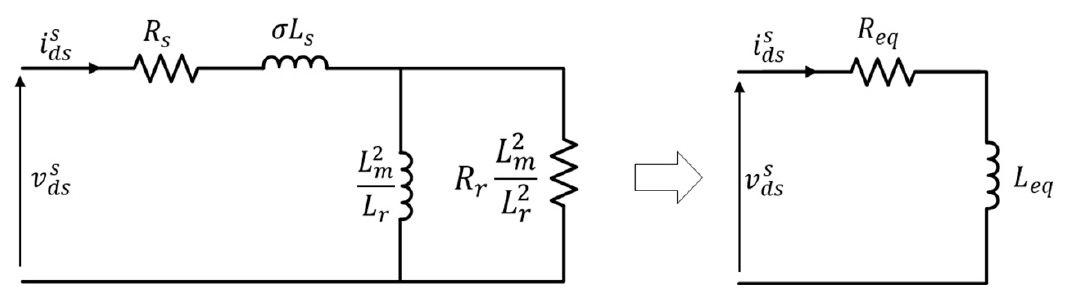
Figure 3. Stationary d -axis equivalent circuit of high frequency signal voltage model at standstill.